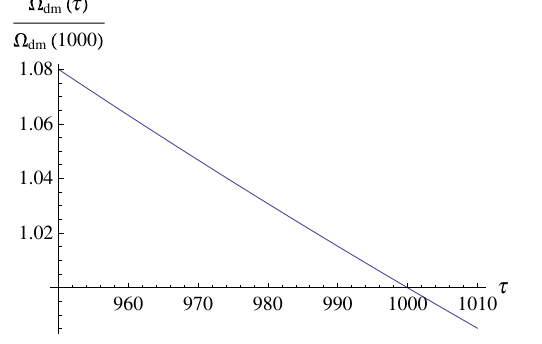
Fig. 5 The dependence d (cid:5) de Note that, for negative value of d (cid:5) de the dark energy to the dark matter and for the positive value of d (cid:5) de the energy is transfered from the dark matter to the dark energy. The rescaled time τ is given in unit [ 1 . 3 × 10 − 40 s ]